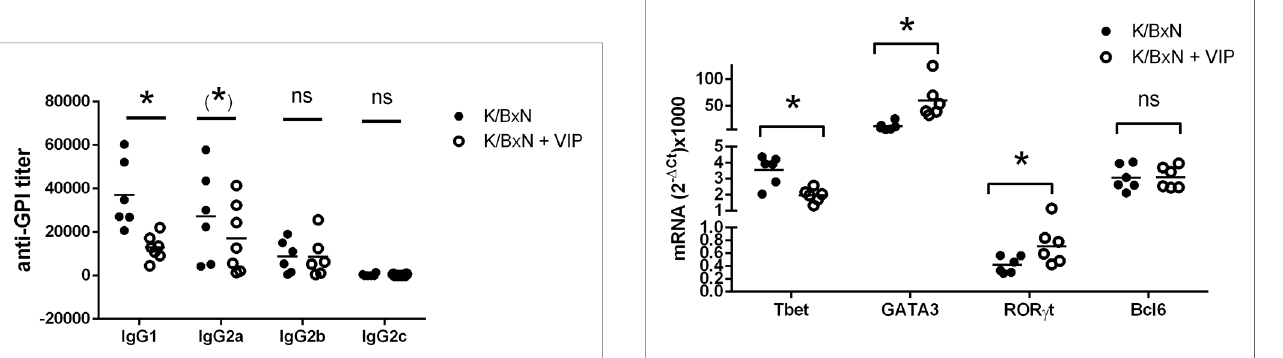
FIGURE 2 | Anti-GPI titers of different isotypes in K/BxN mice treated with PBS or VIP for 15 days. Mean is shown as the horizontal line within each group; each symbol represents an individual mouse. *p < 0.05; *0.05 < p < 0.1; ns, not signi fi cant.